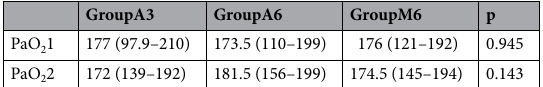
Table 3. PaO 2 Values (mmHg, median,